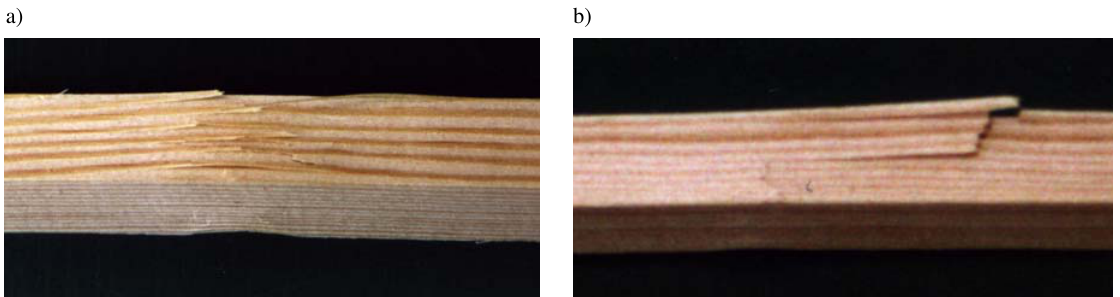
Fig 13. Long-fibre fractures of natural samples after static bending tests: a) at 20 ° C; b) at 200 ° C